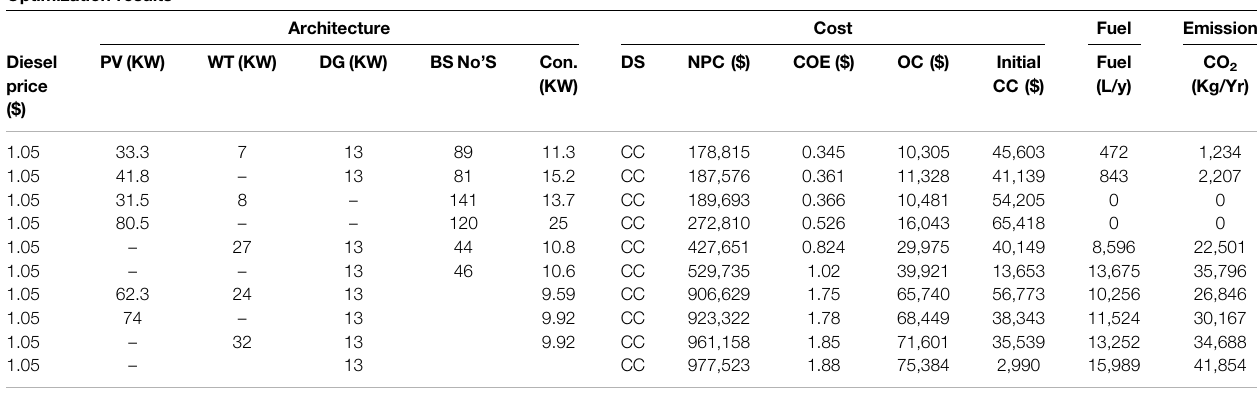
TABLE 10 | HOMER optimization results of the PV/Wind/Diesel/Battery system for Ooty. Optimization results Architecture